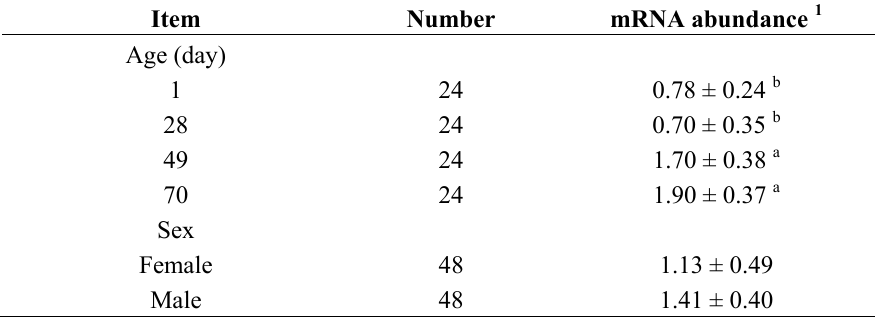
Table 3. The abundance of MUSTN1 mRNA by age, sex, and tissue interactions among